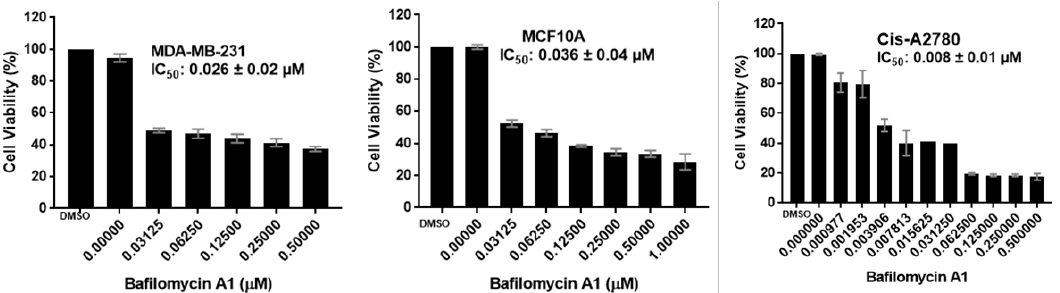
Figure 9. The cell viability (%) relative to untreated control cells of breast cancer (MDA-MB-231), breast normal (MCF10A) cell lines, and ovarian cancer (Cis-A2780) cell line following the exposure of various concentrations of standard Baf A1 for 48 h.